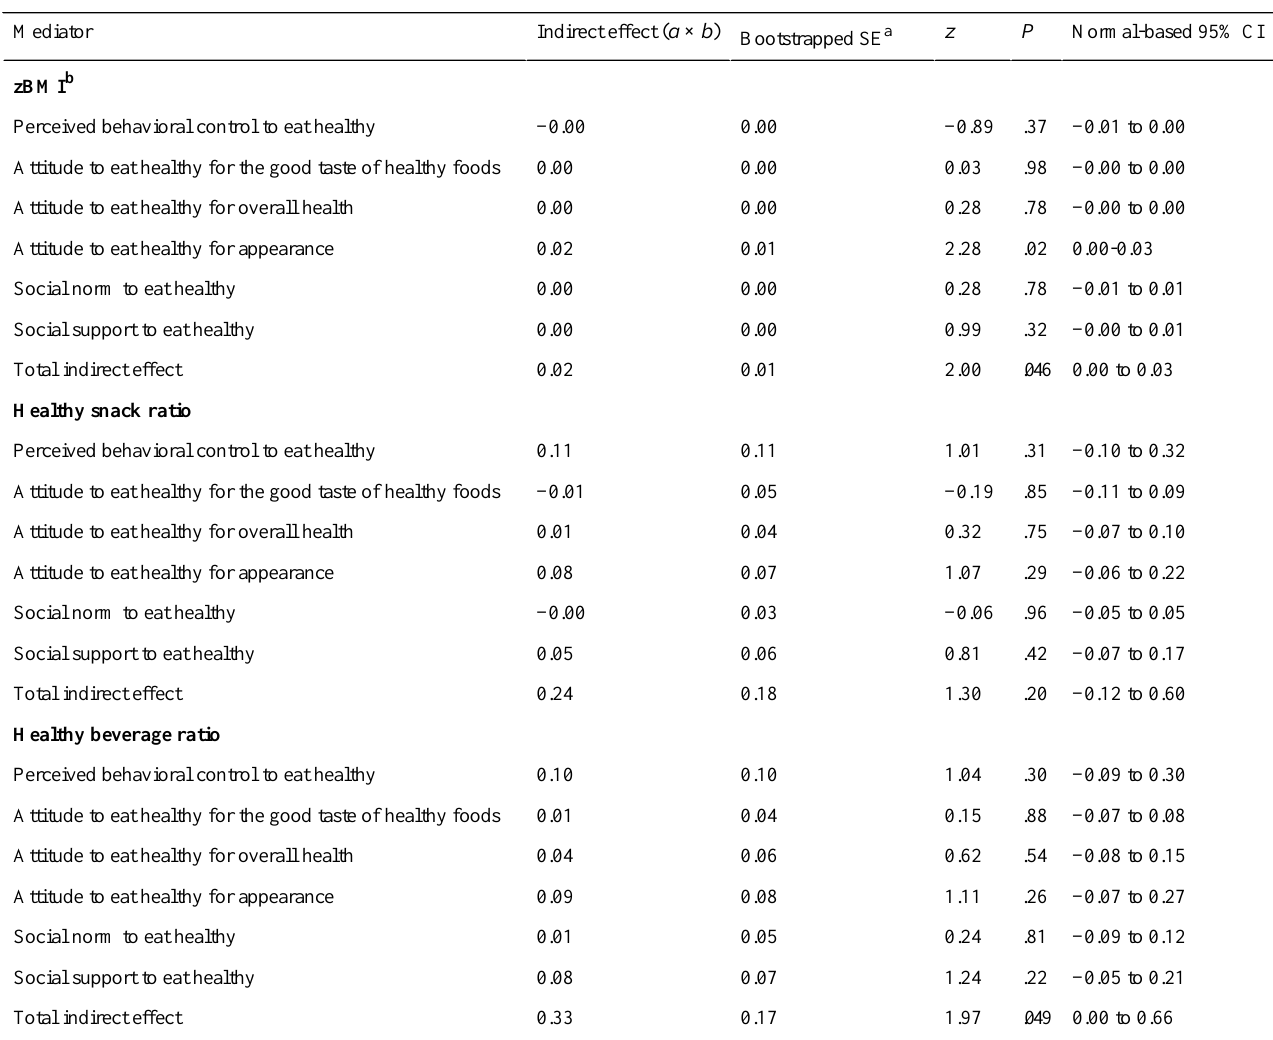
Table 3. Indirect effects multiple mediation with fitness app use